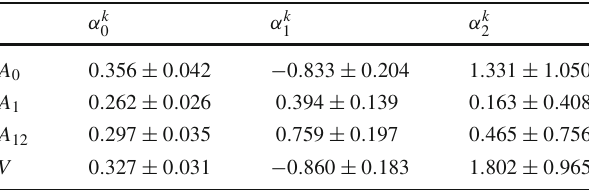
Table 3 Parameters used for the determination of the ¯ B → ρ(cid:2) − ¯ ν (cid:2) form factors as given in Ref. [37]